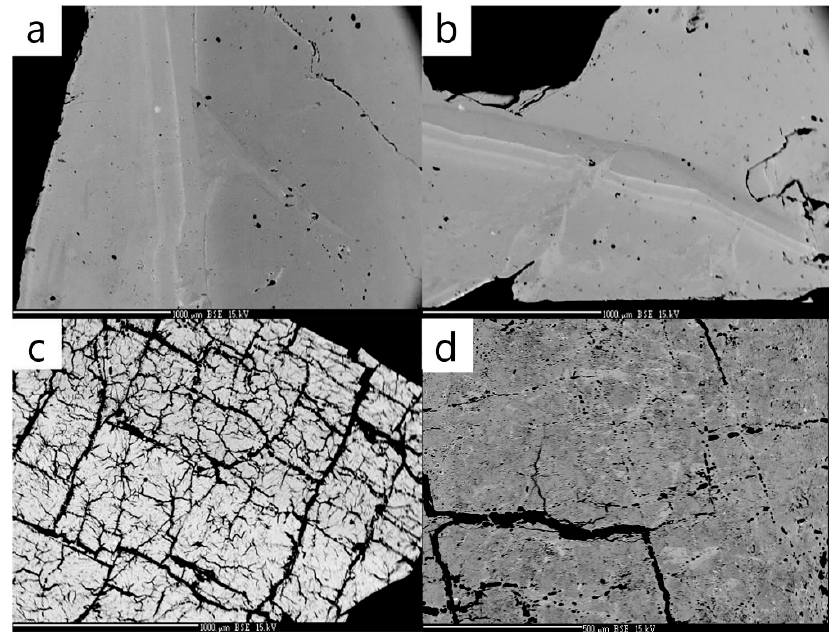
Figure 1. BSE images of heat-treated epidote: ( a ) ES-0; ( b ) ES-9; ( c ) ES-10; ( d ) ES-11. The untreated natural sample ( a ) and sample treated at 900 ◦ C ( b ) displayed only the weak chemical zoning caused by small variations in Al and Fe 3+ content; samples heated over 1000 ◦ C formed breakdown products firstly as a homogeneous mass ( c ), while those heated at 1100 ◦ C formed domains with a slightly different composition ( d